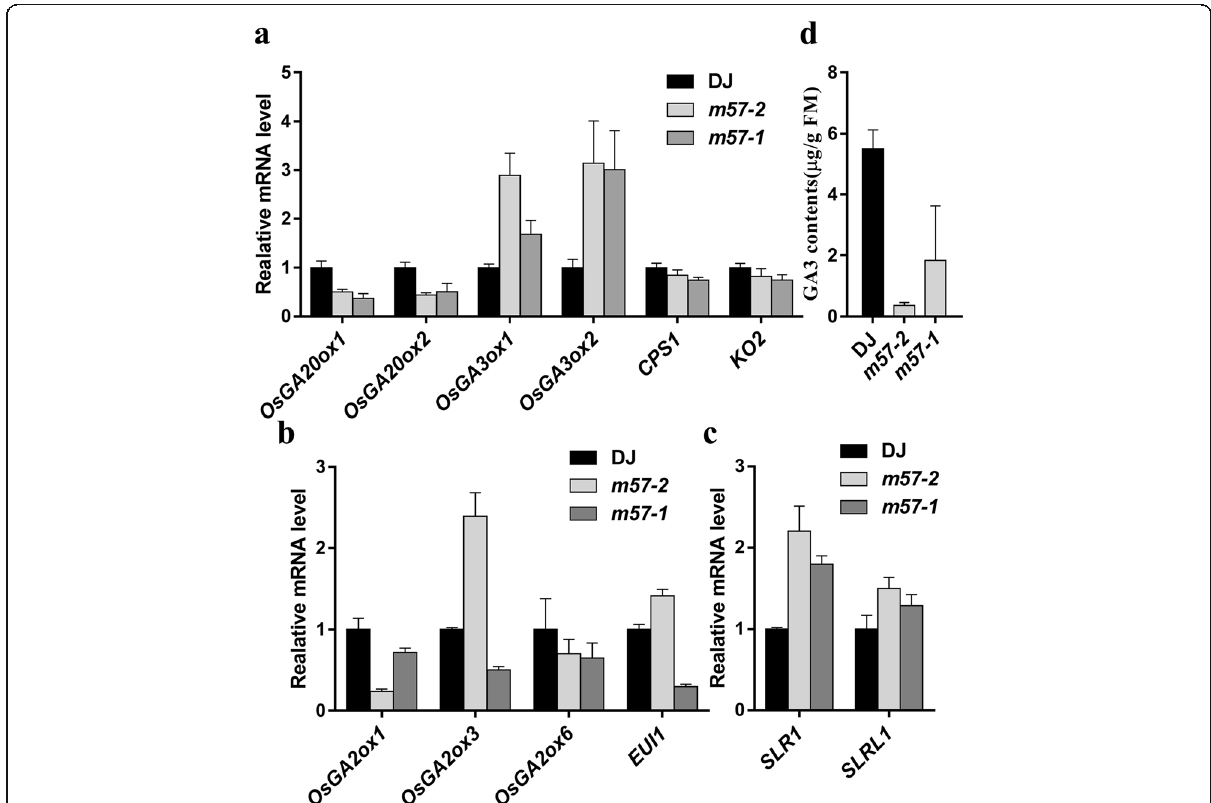
Fig. 4 OsMADS57 regulate the expression of GA metabolic genes. a - c Altered expression of genes involved in GA metabolism ( a and b ) and signaling ( c ). Expression of genes involved in GA metabolism and signaling was analysed by Q-PCR in wild type and mutants lines. The PCR signals were normalized with that from actin1 transcripts. Transcript levels from wild type were set at 1. d Quantification of GA 3 in four-leaf stage seedlings. DJ, wild type; m57 – 2 , osmads57 – 2 ; m57 – 1 , osmads57 – 1 . Three independent experiments were conducted with similar results. Data are means ± SE ( n = 10). Error bars indicate